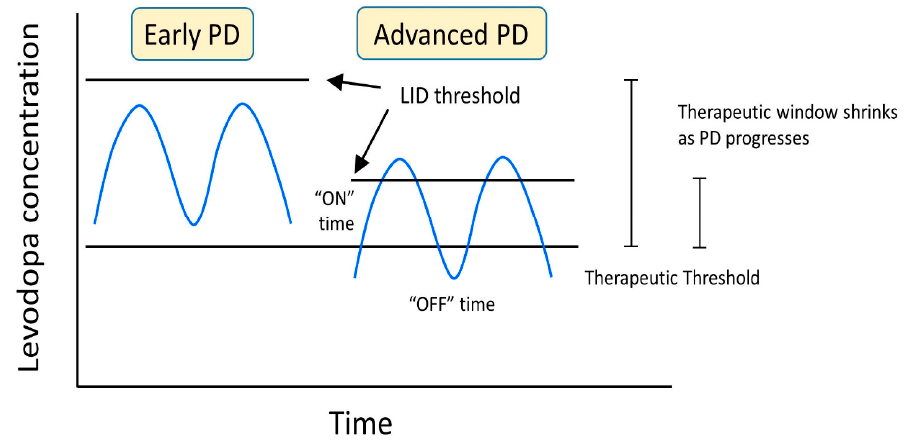
Figure 5. LID developmental changes as a result of levodopa concentration and progression of PD